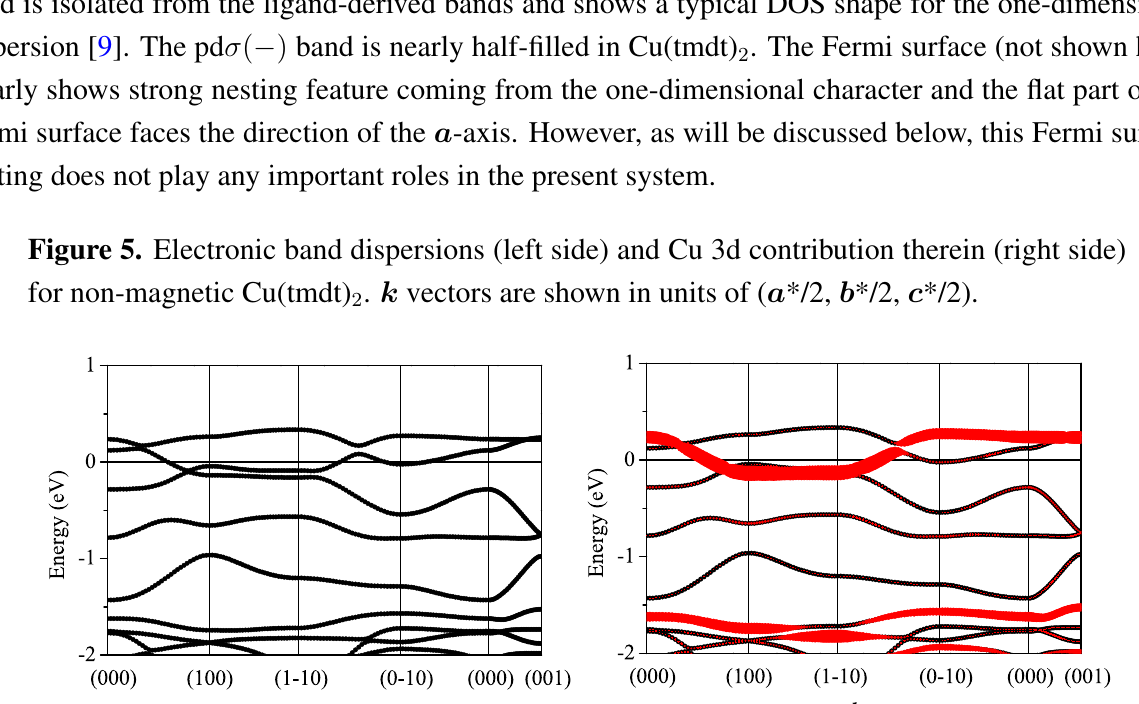
Figure 6. Electronic density of states for non-magnetic Cu(tmdt) states from Cu 3d and four S atoms surrounding Cu (S